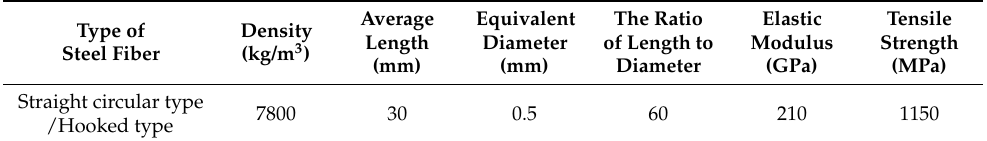
Table 2. Characteristic parameters of the steel